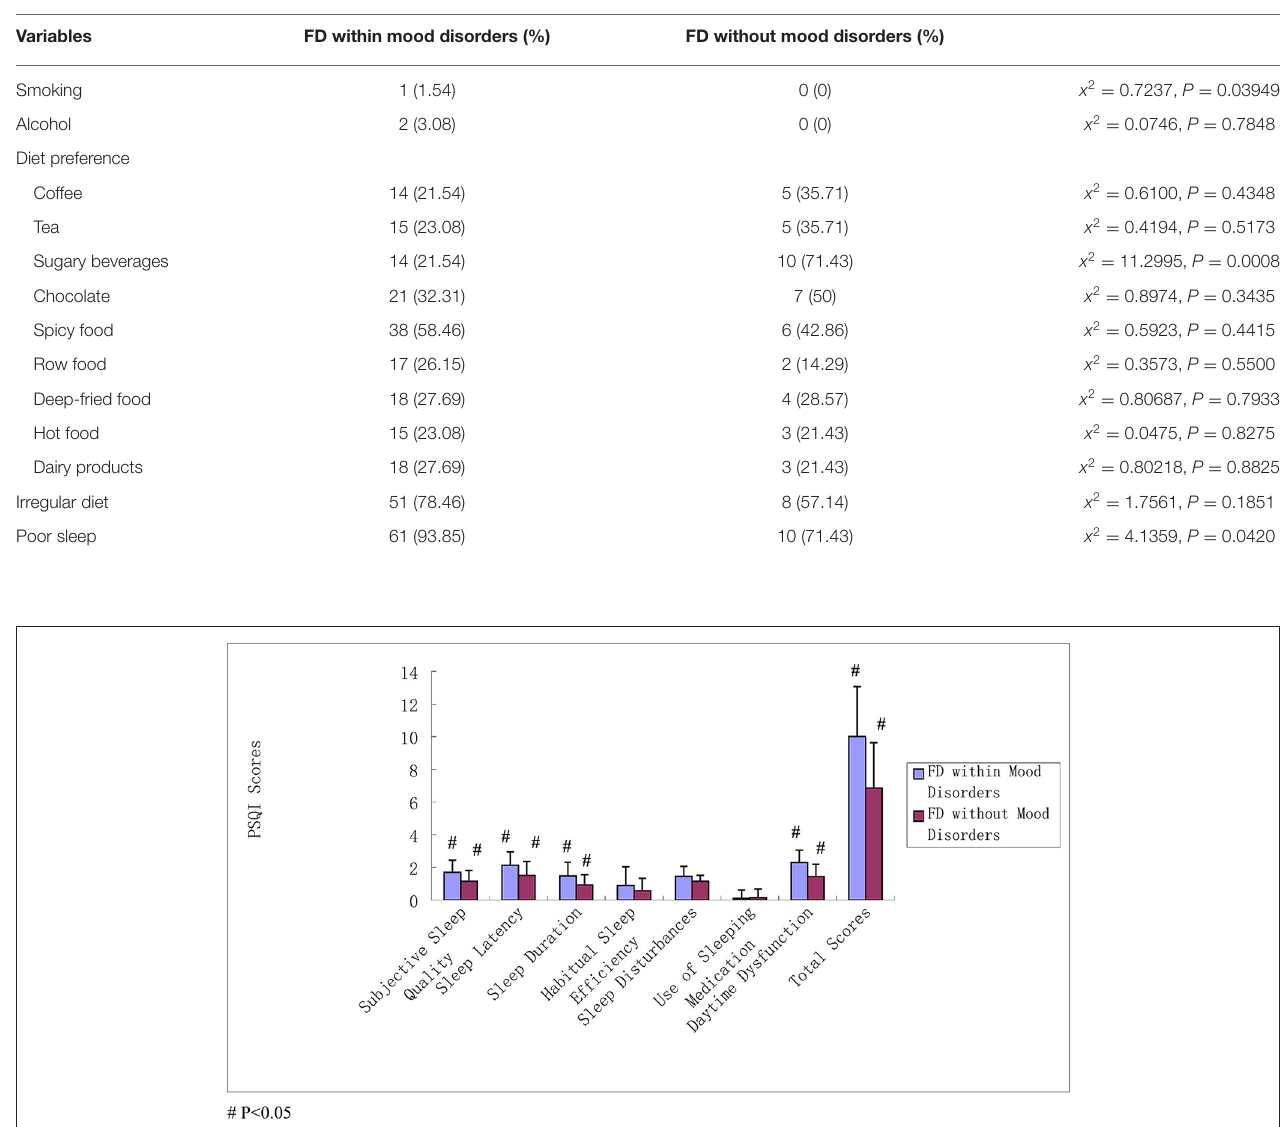
TABLE 6 | Lifestyles among neonatal nurses in FD with mood disorders.